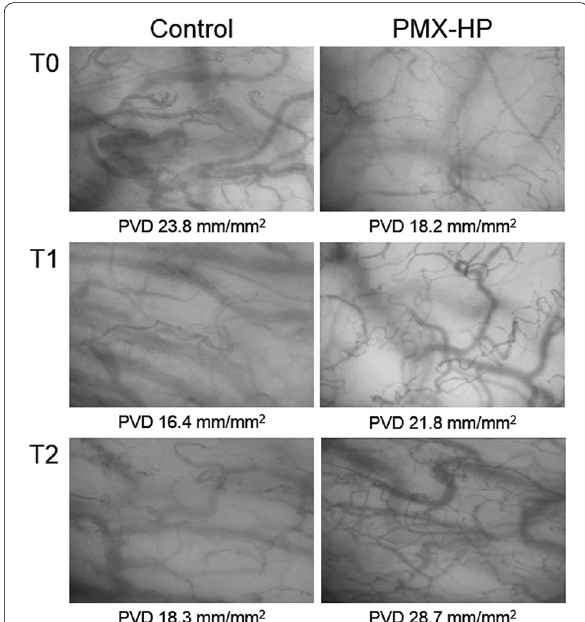
Fig. 2 Sublingual microcirculation images in patients with sepsis. Time points: T0, at enrollment; T1, at 24–26 h after enrollment; and T2, 48 h after enrollment. PMX ‑ HP polymyxin B hemoperfusion, PVD perfused vessel